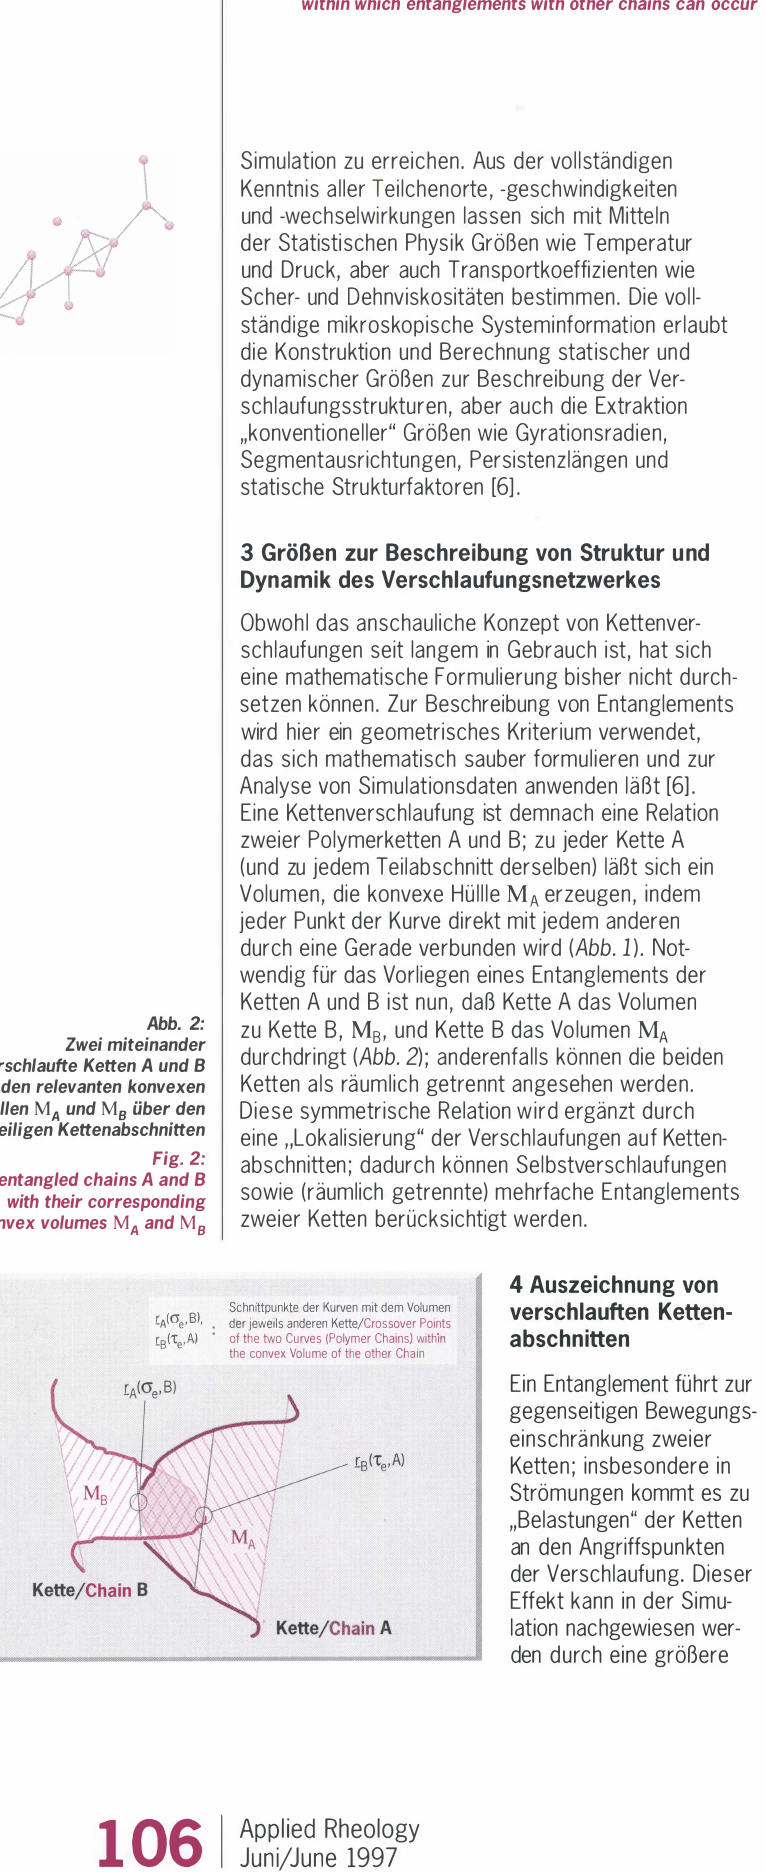
Polymer chains and their corresponding convex volume